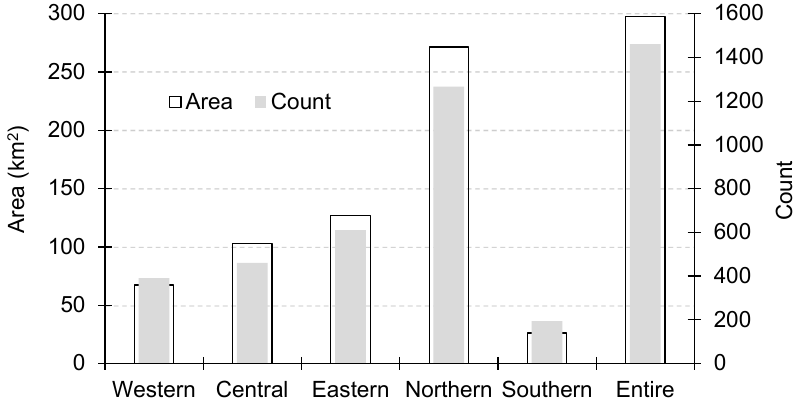
Figure 3. Rock glacier area and count comparison for the different sections and slopes of the Greater Caucasus.